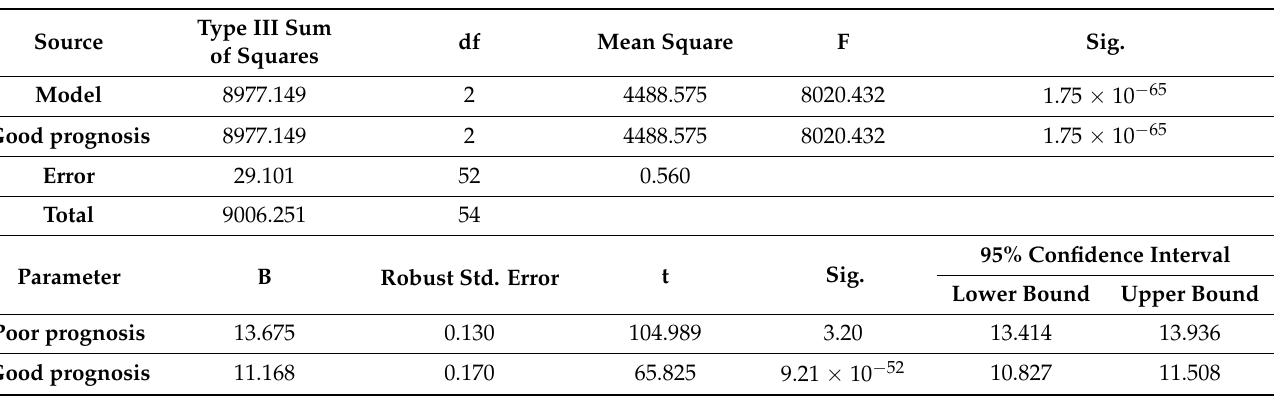
Table 4. Results of Univariate Analysis of Variance (ANOVA) among patients infected with SARS- CoV-2 that received dexamethasone treatment for 48 h (with good and poor prognosis). The coefficient of determination (R squared) of the model was 0.997, suggestive of good model fit with sufficient predictive